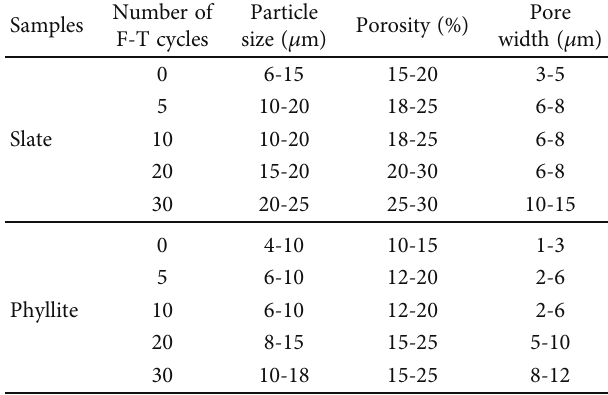
Table 2: SEM parameters of the low-grade metamorphic rock samples.